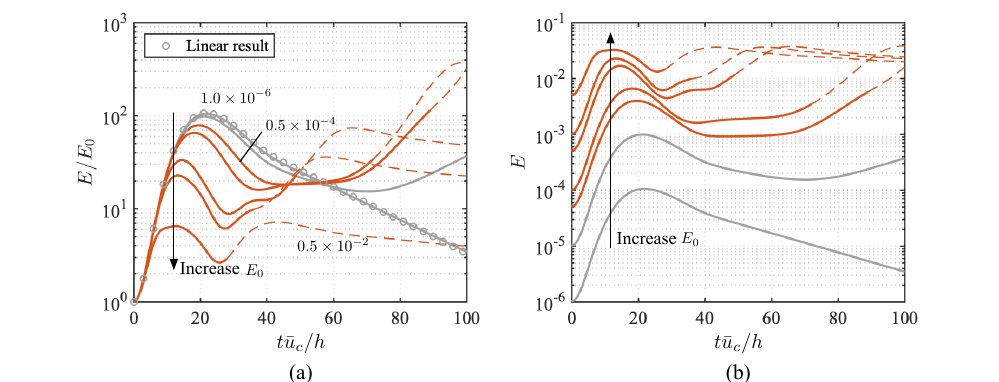
Figure 4. Time evolution of kinetic energy density E of case ( α , β ) = ( 1,1 ) initialized by different amplitudes of optimal disturbance E 0 : Red lines represent transition cases, and grey lines denote that the flow remains laminar. Dashed line indicates that the flow is in turbulent state. ( a ) Kinetic energy density normalized by its initial value E / E 0 and ( b ) kinetic energy density E